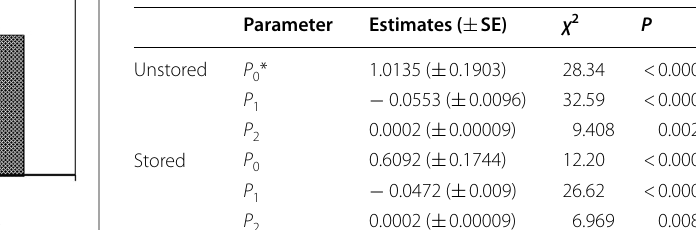
Fig. 1 Mean ( SE) longevity of Eretmocerus mundus adults ± obtained from unstored and eight-day-stored pupae. Means are not significantly different based on t test (> P : 0.05)